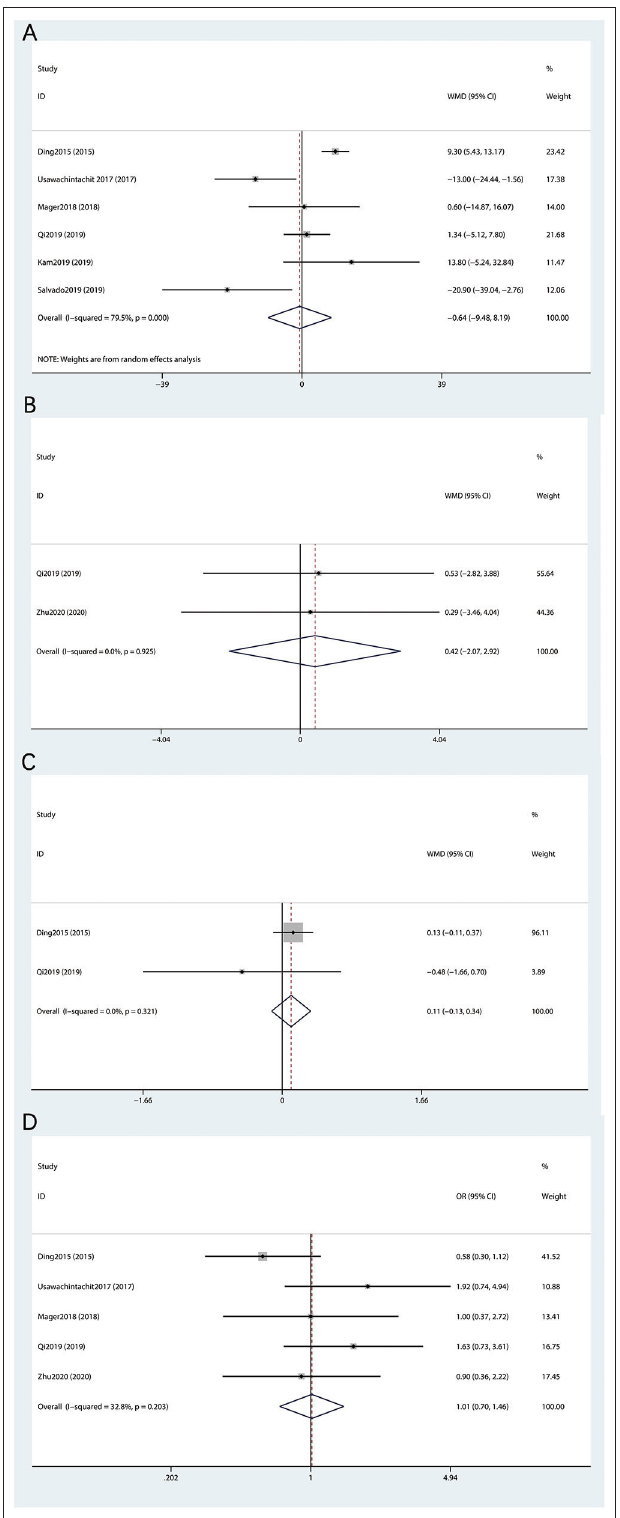
FIGURE 2 | Forest plot of perioperative outcomes between the su-fURS and ru-fURS. (A) operative time, (B) estimated blood loss, (C) length of hospital stay, and (D) stone-free